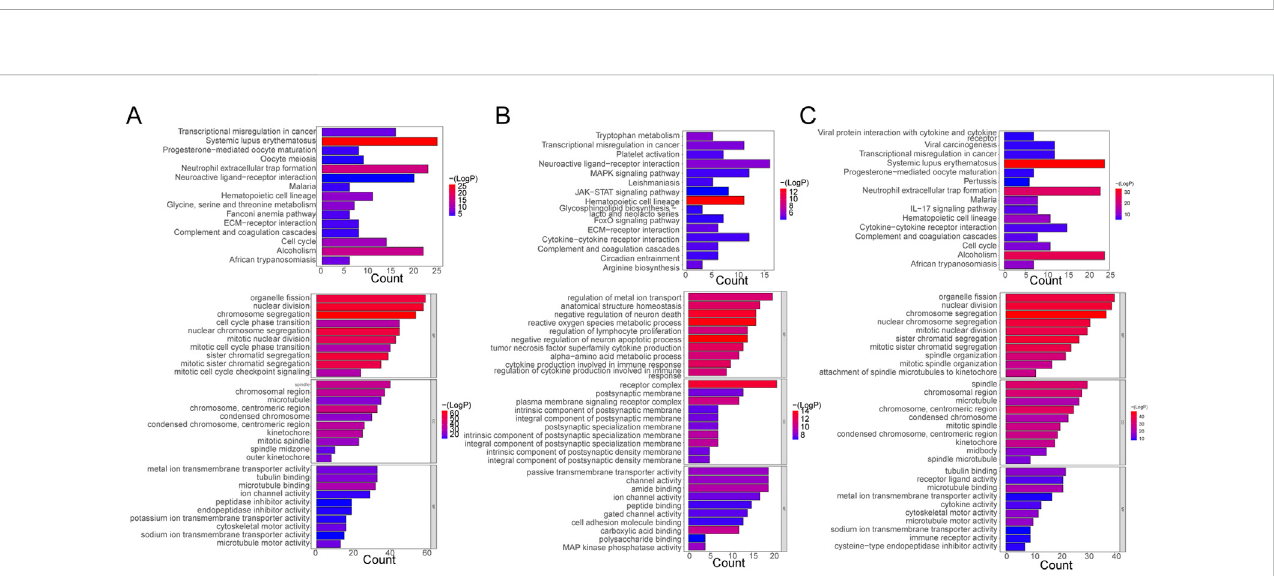
FIGURE 2 Functional Enrichment Analysis. (A) Bar plots of KEGG pathway and GO enrichment analyses in the control and case groups. (B) Bar plots of KEGG pathway and GO enrichment analyses in the case and treatment groups. (C) Bar plots of KEGG pathway and GO enrichment analyses in the control and case groups. Each GO map presents the top 10 enriched terms in BP, CC, and MF. Each KEGG map shows the top 15 enriched KEGG